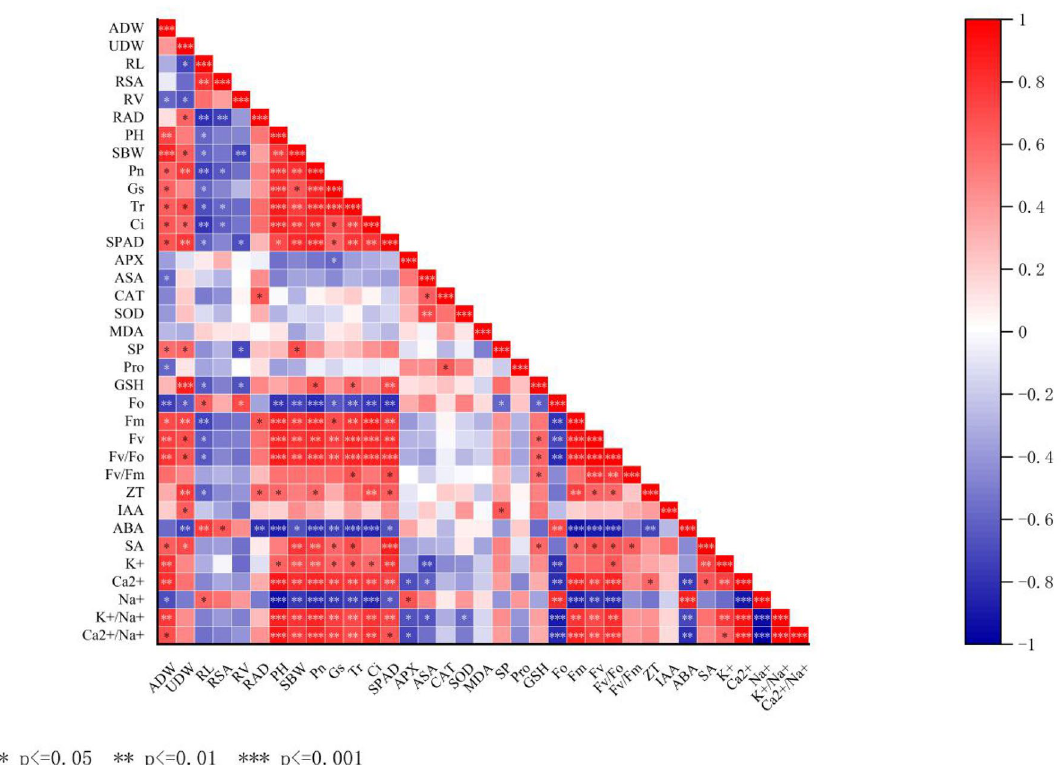
Figure 12. Correlation analysis among the indicators measured of rice seedlings. ADW aboveground dry weight, UDW underground dry weight, RL root length, RSA root surface area, RV root volume, PH plant height, SBW stem width, Pn net photosynthetic rate, Gs stomatal conductance, Tr transpiration rate, Ci intercellular carbon dioxide concentration, SP soluble protein, Pro